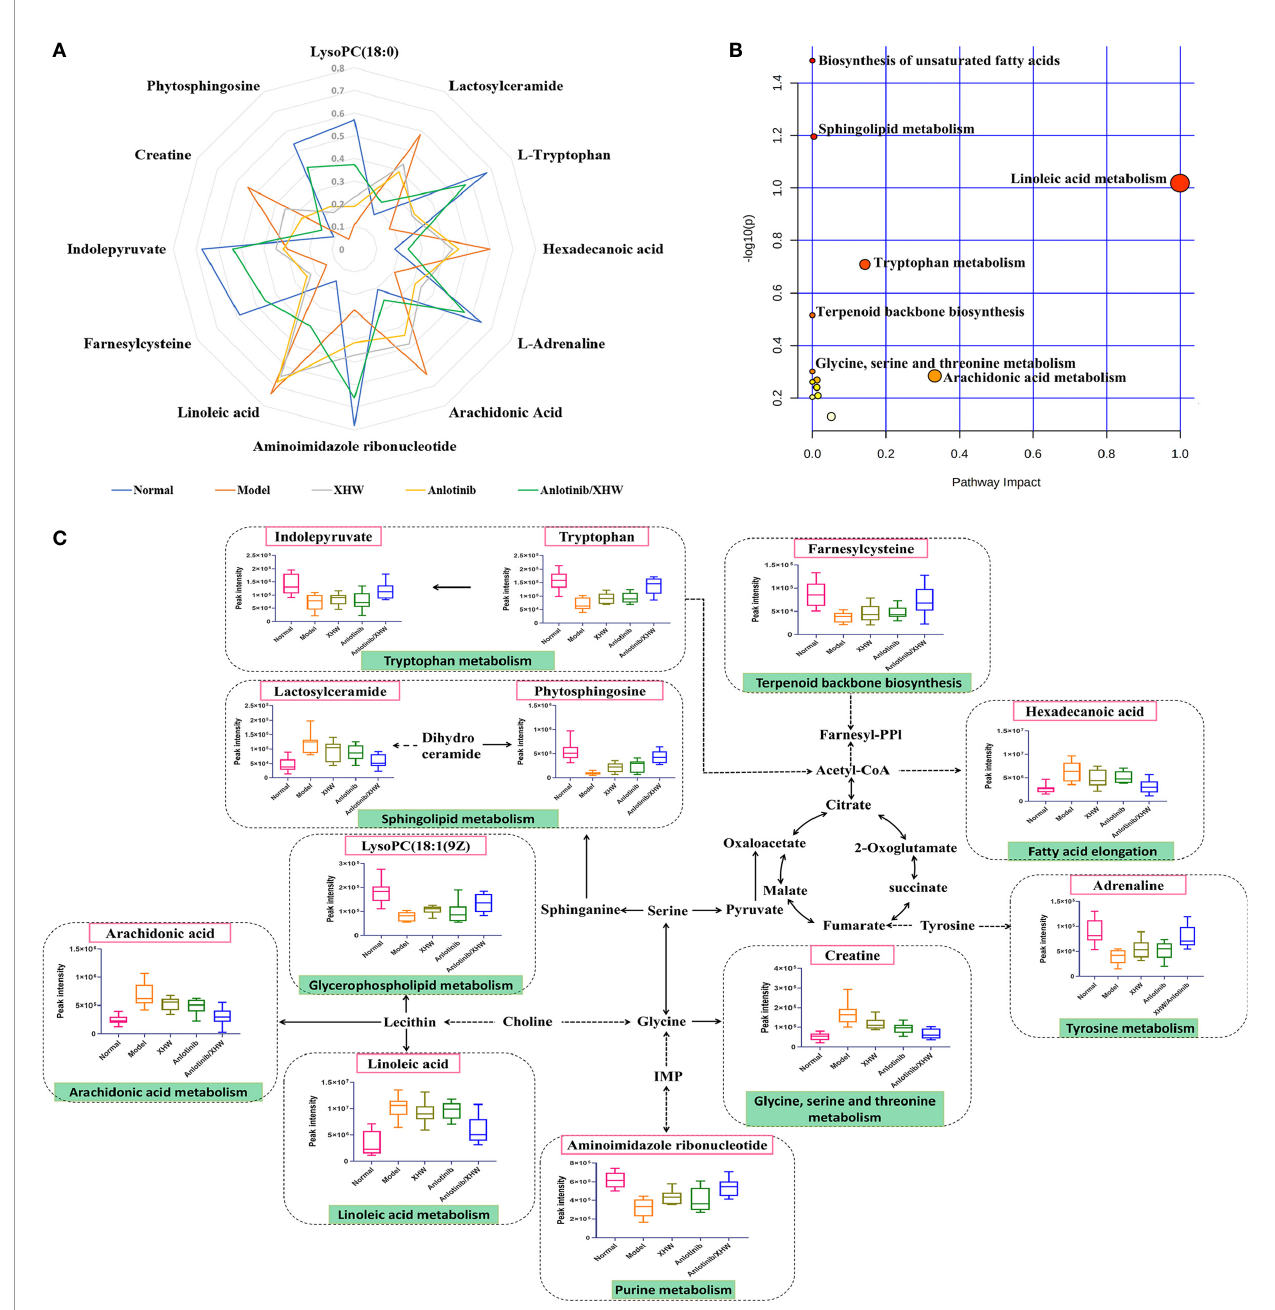
FIGURE 5 | Overall metabolic pro fi le. (A) Spider plot of 12 metabolites for which the change in relative abundance best differentiated the fi ve experimental groups. (B) Schematic diagram of the affected metabolic pathways. (C) Network map of metabolic pathways and